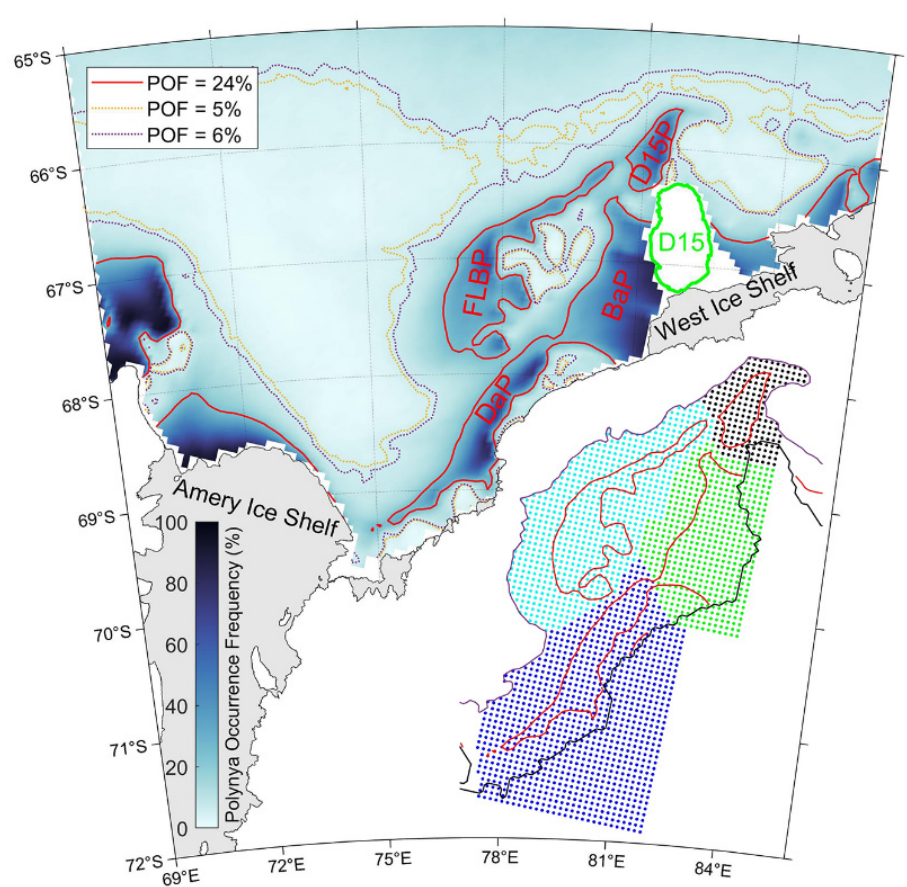
Figure 2. POF and polynya-masks (the inset in the lower right corner) of the four polynyas in eastern Prydz Bay.